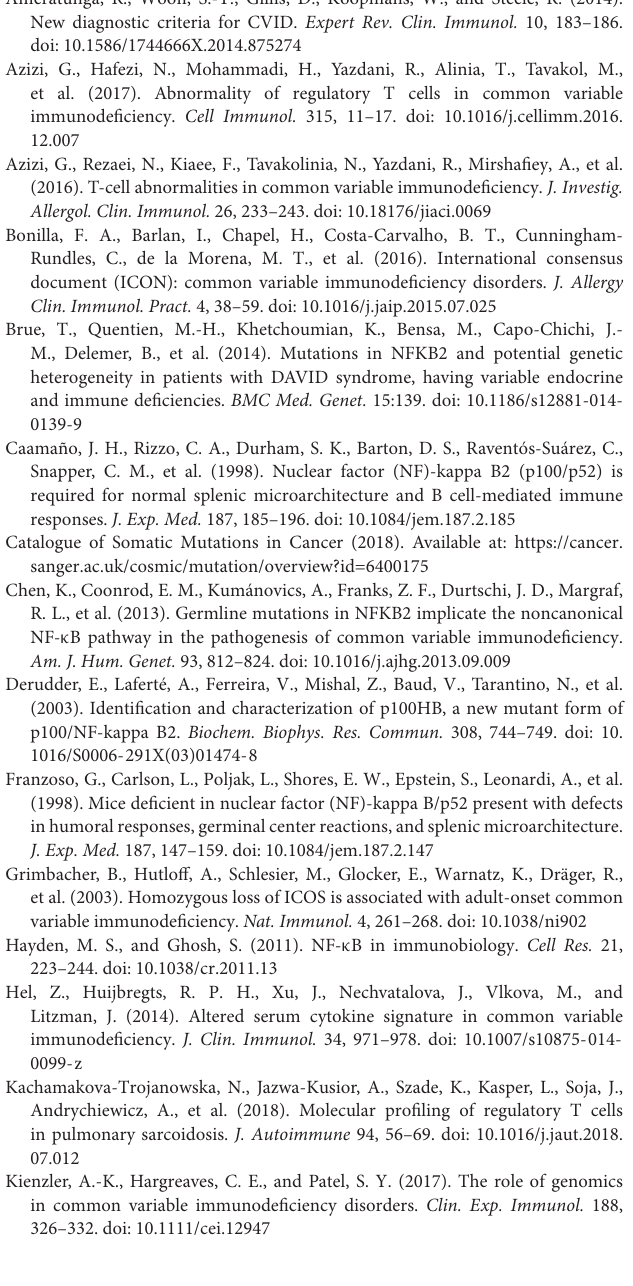
(B,C) Presence of mutation was confirmed by Sanger sequencing in proband’s sample and tested in other family members.